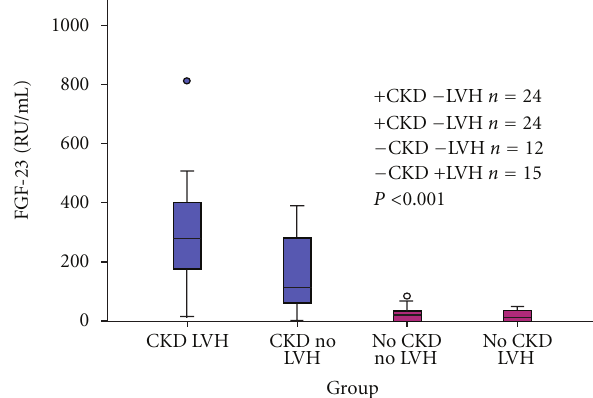
Figure 1: FGF-23 concentration stratified according to the presence or absence of CKD and LVH.